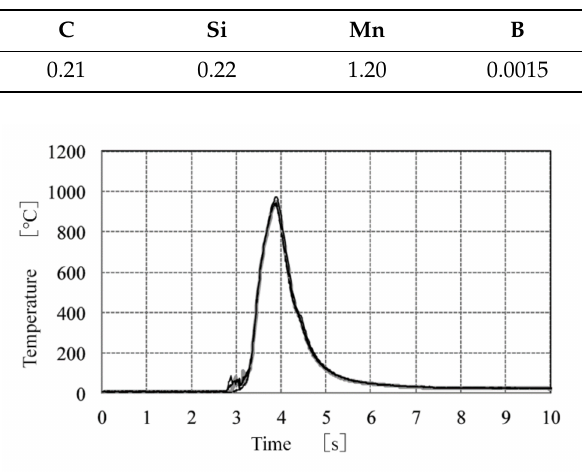
Figure 5. Example of tube temperature of in 3DQ process (feed speed 80 mm / s).